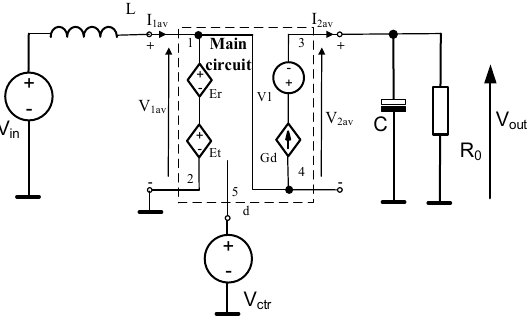
Figure 2. Simulation diagram of the boost converter.